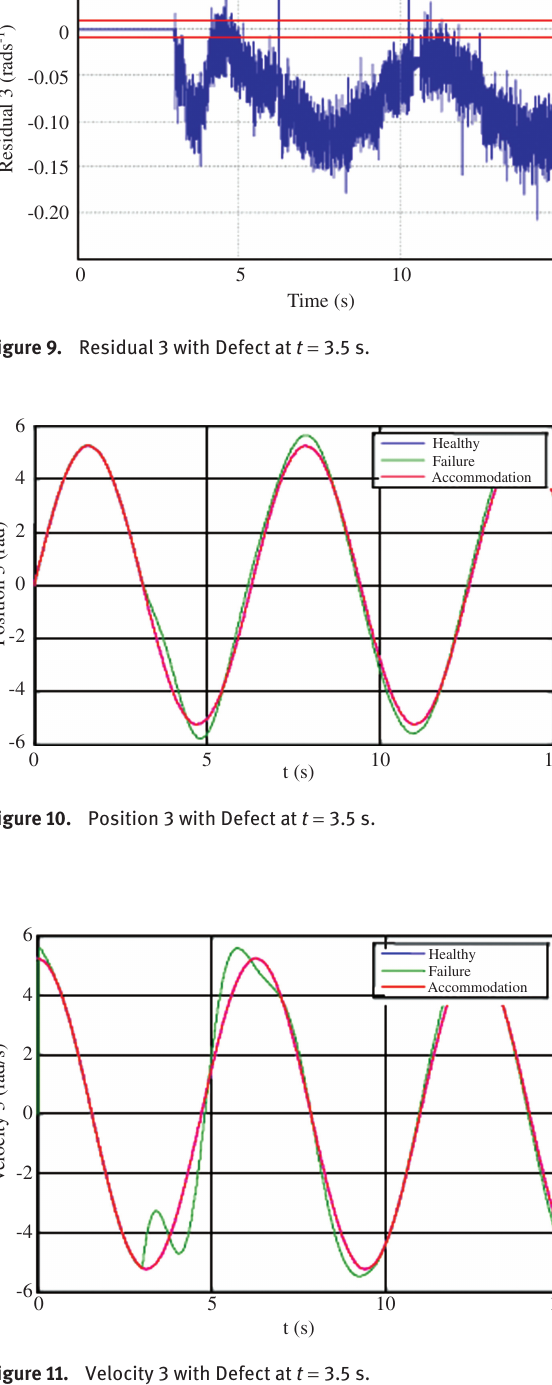
Figure 11. Velocity 3 with Defect at t = 3.5